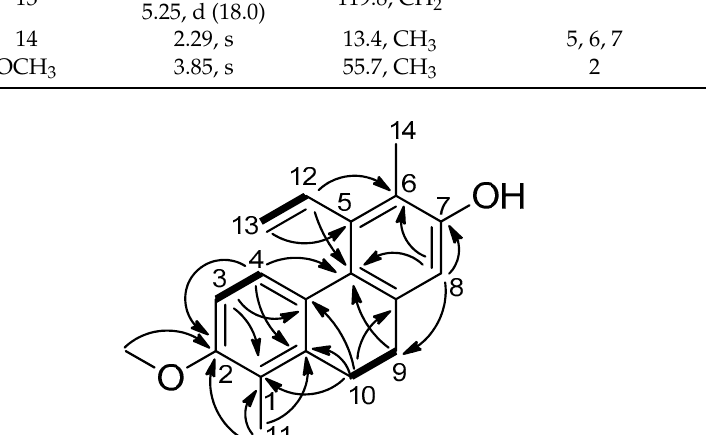
Figure 2. Diagnostic COSY ( ▬ ) and HMBC (H → C) correlations of Compound 1 .